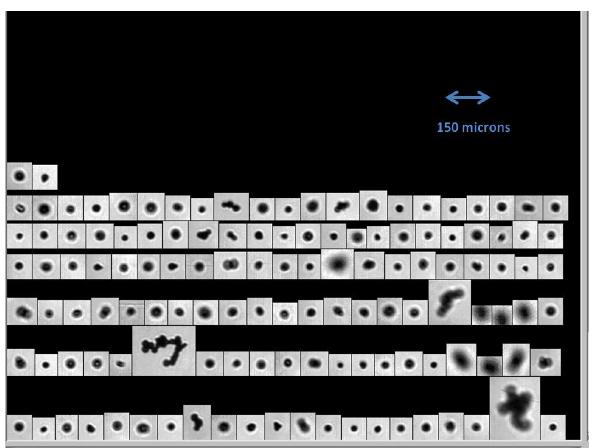
Fig. 5. CPI images of ice particles sampled between 22:13:04 and 22:13:06.